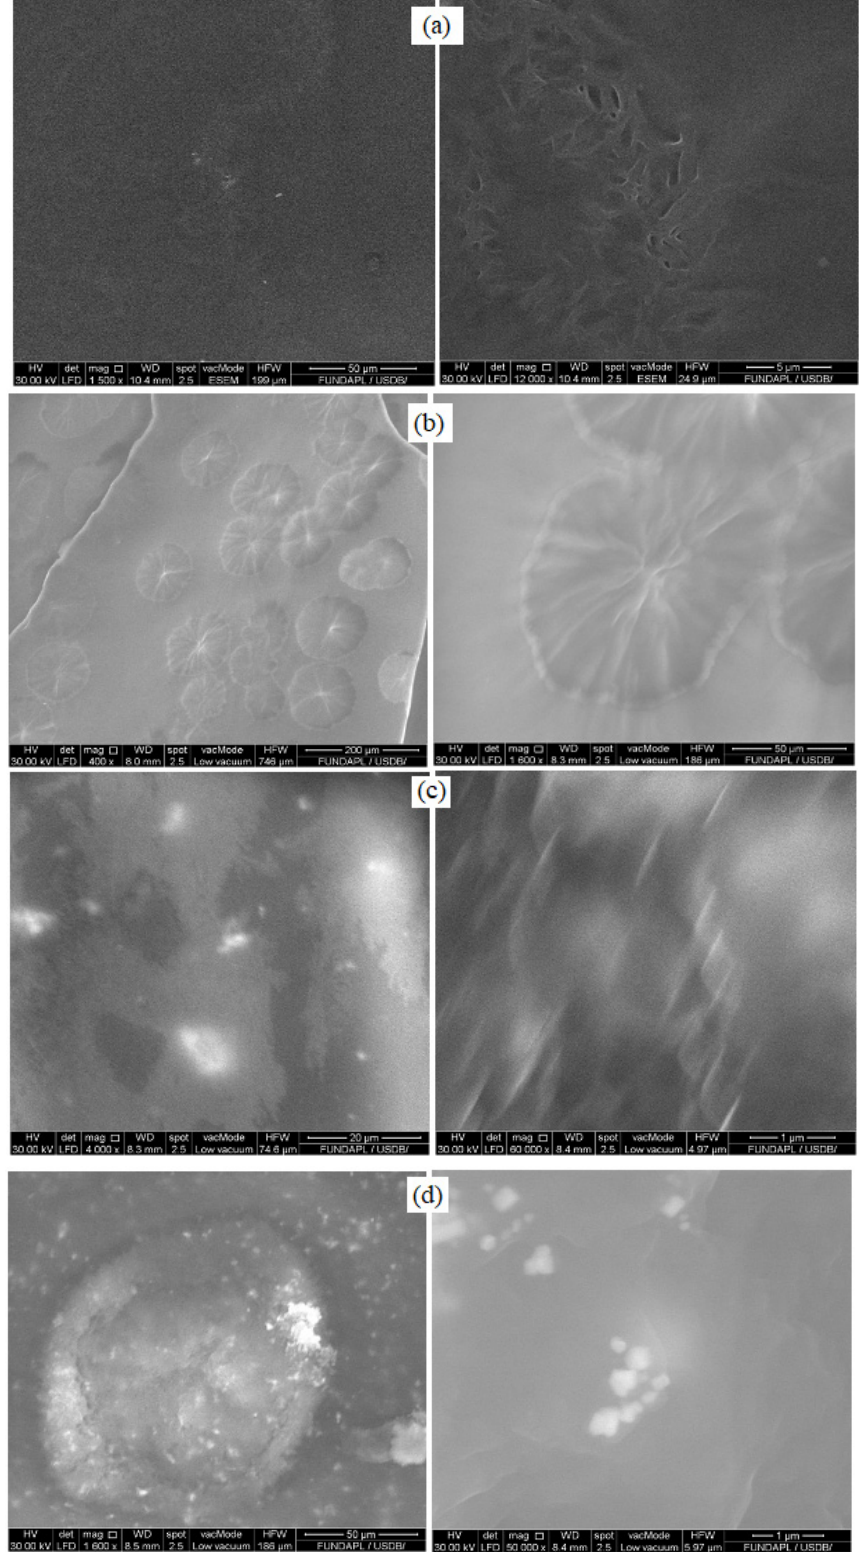
Figure 1. Scanning electron microscopy micrographs of the following polymer blends and nanocomposites: ( a ) 7PMMA/3PEG, ( b ) 3PMMA/7PEG, ( c ) 7PMMA/3PEG/ZnO and ( d ) 3PMMA/7PEG/ZnO.